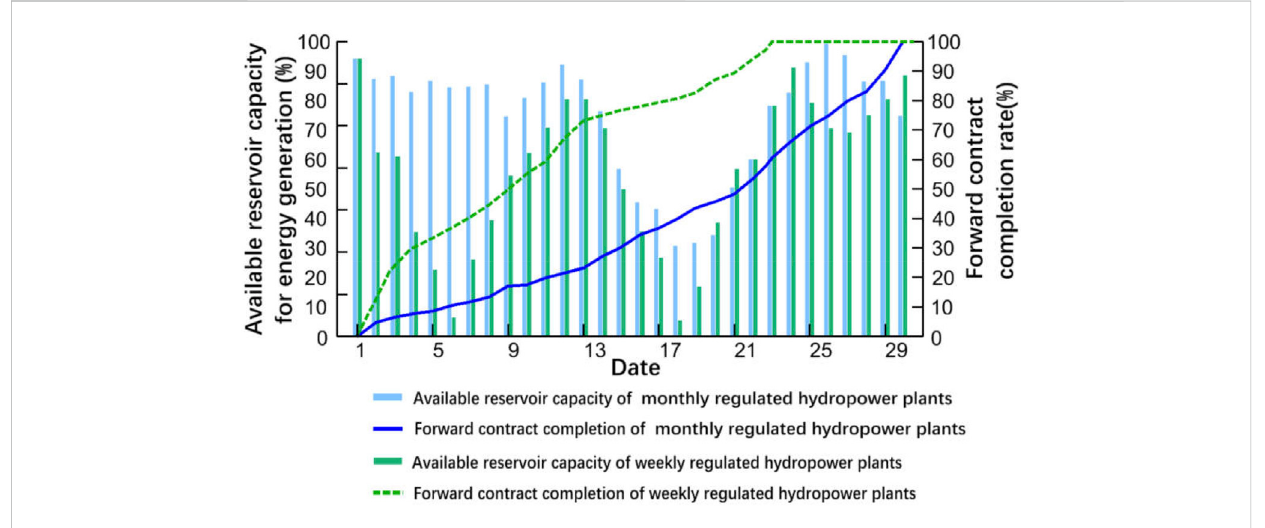
FIGURE 12 Optimization results for hydropower plants with different regulation